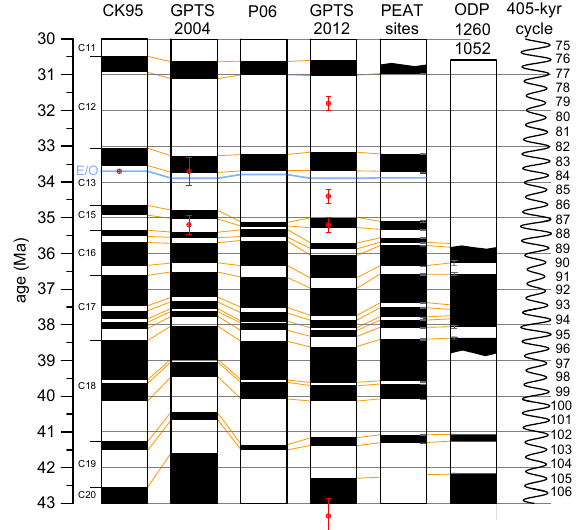
Figure 9. Comparison of magnetochron boundary ages and dura- tions for Chron C12 to C19 based on estimates from Cande and Kent (1995; CK95), Ogg and Smith (2004; GPTS 2004), Pälike et al., (2006; P06), Ogg (2012; GPTS 2012), Pacific Equatorial Age Tran- sect (PEAT; this study), and combined ODP Sites 1052 and 1260 (this study). Orange lines track changes between different estimates. Calibration points with error bar used by CK95, GPTS2004 and GPTS2012 are plotted in red dots. Also given is the respective ab- solute age of the Eocene–Oligocene boundary (E–O; blue line) and the long eccentricity cycle number for reference (see Supplement Fig.